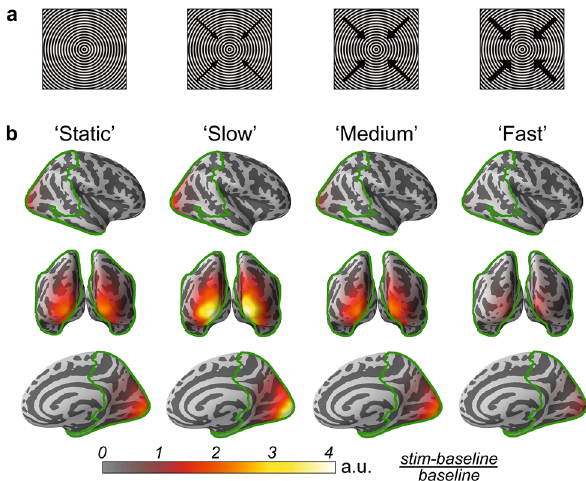
Figure 1. The gratings used to induce the visual gamma response (GR) ( a ) and source localization of the grand average GR power for each stimulus type ( b ). ‘Static’, ‘slow’ (1.2°/s), ‘medium’ (3.6°/s), ‘fast’ (6.0°/s) refer to the gratings’ drift rate; the arrows indicate the direction, and their thickness indicates the relative velocity of the visual motion. Color-coded cortical maps depict baseline-normalized GR power: (GR stimulation – GR baseline )/ GR baseline . Green borders outline the combined visual parcels used for source